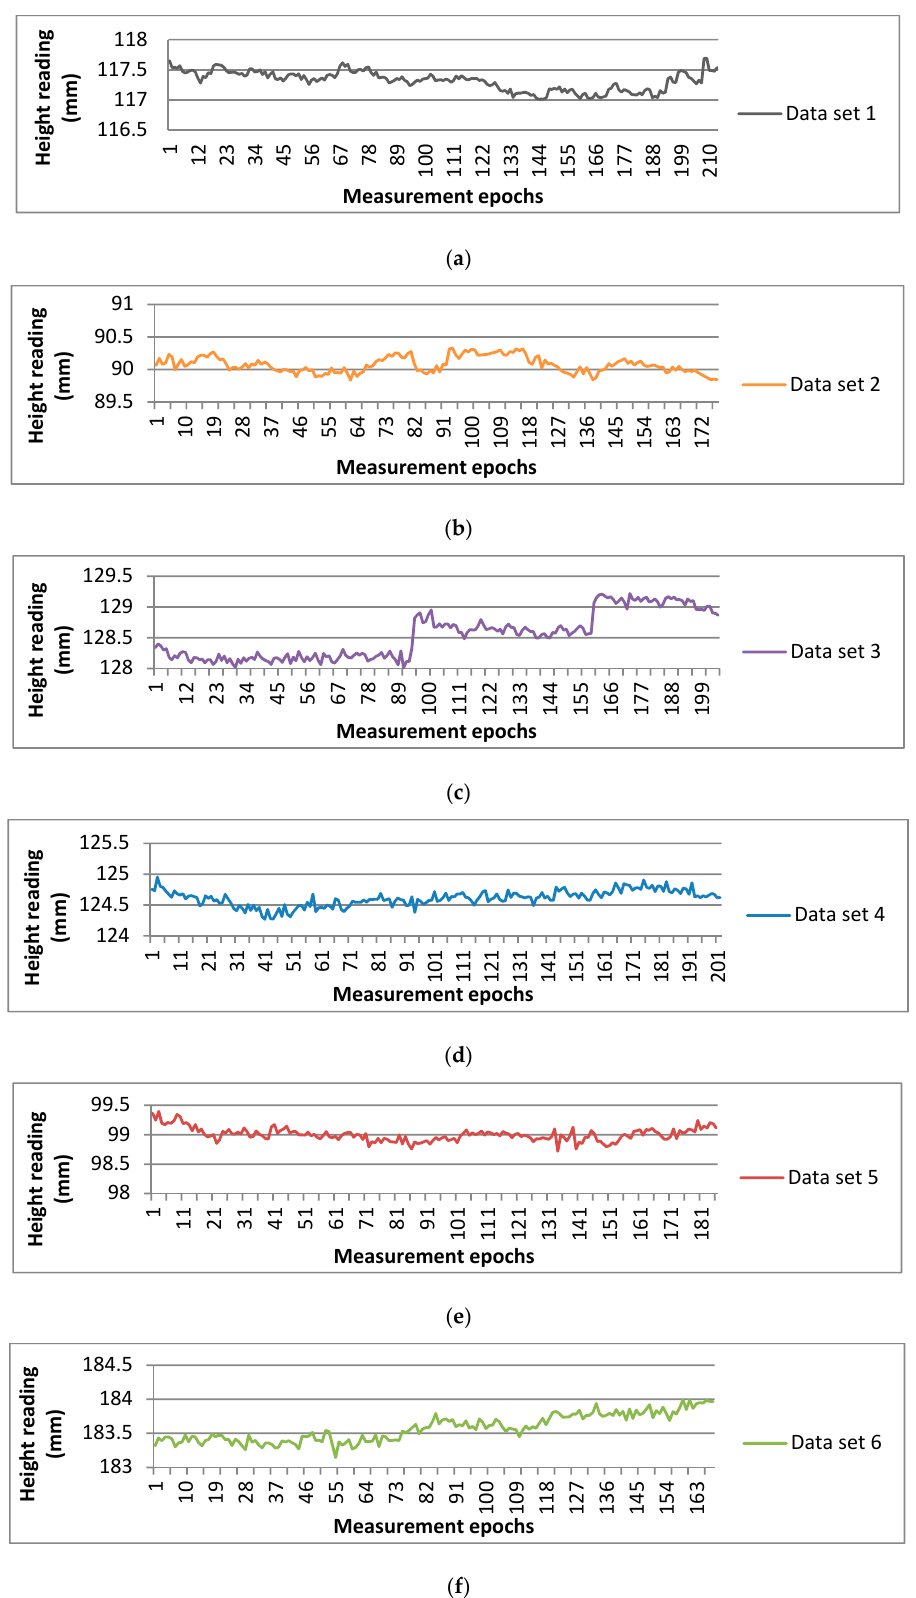
Figure 14. The data sets of the barcode height readings in di ff erent environments when the camera is static, ( a ) Data set 1; ( b ) Data set 2; ( c ) Data set 3; ( d ) Data set 4; ( e ) Data set 5; ( f ) Data set